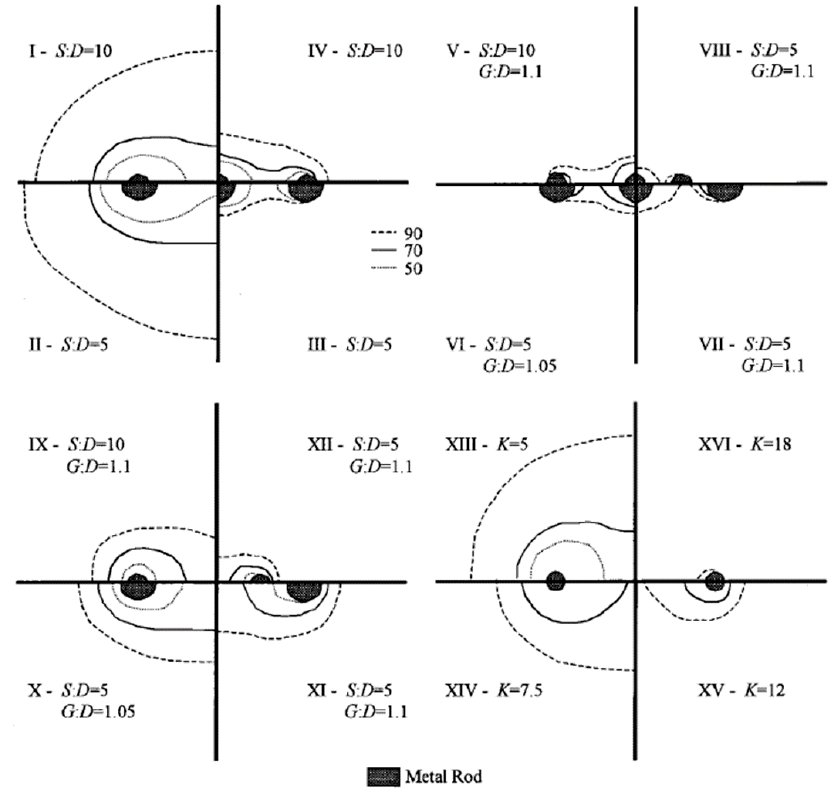
Figure 8. I to IV: percent sample areas of conventional probes; V to XII: coated-rod percent sample areas in a medium with dielectric permittivity 10; and XIII to XVI: coated rods with S : D = 10, G : D = 1.1 surrounded by a soil with uniform dielectric permittivity, K, of varying value [28].